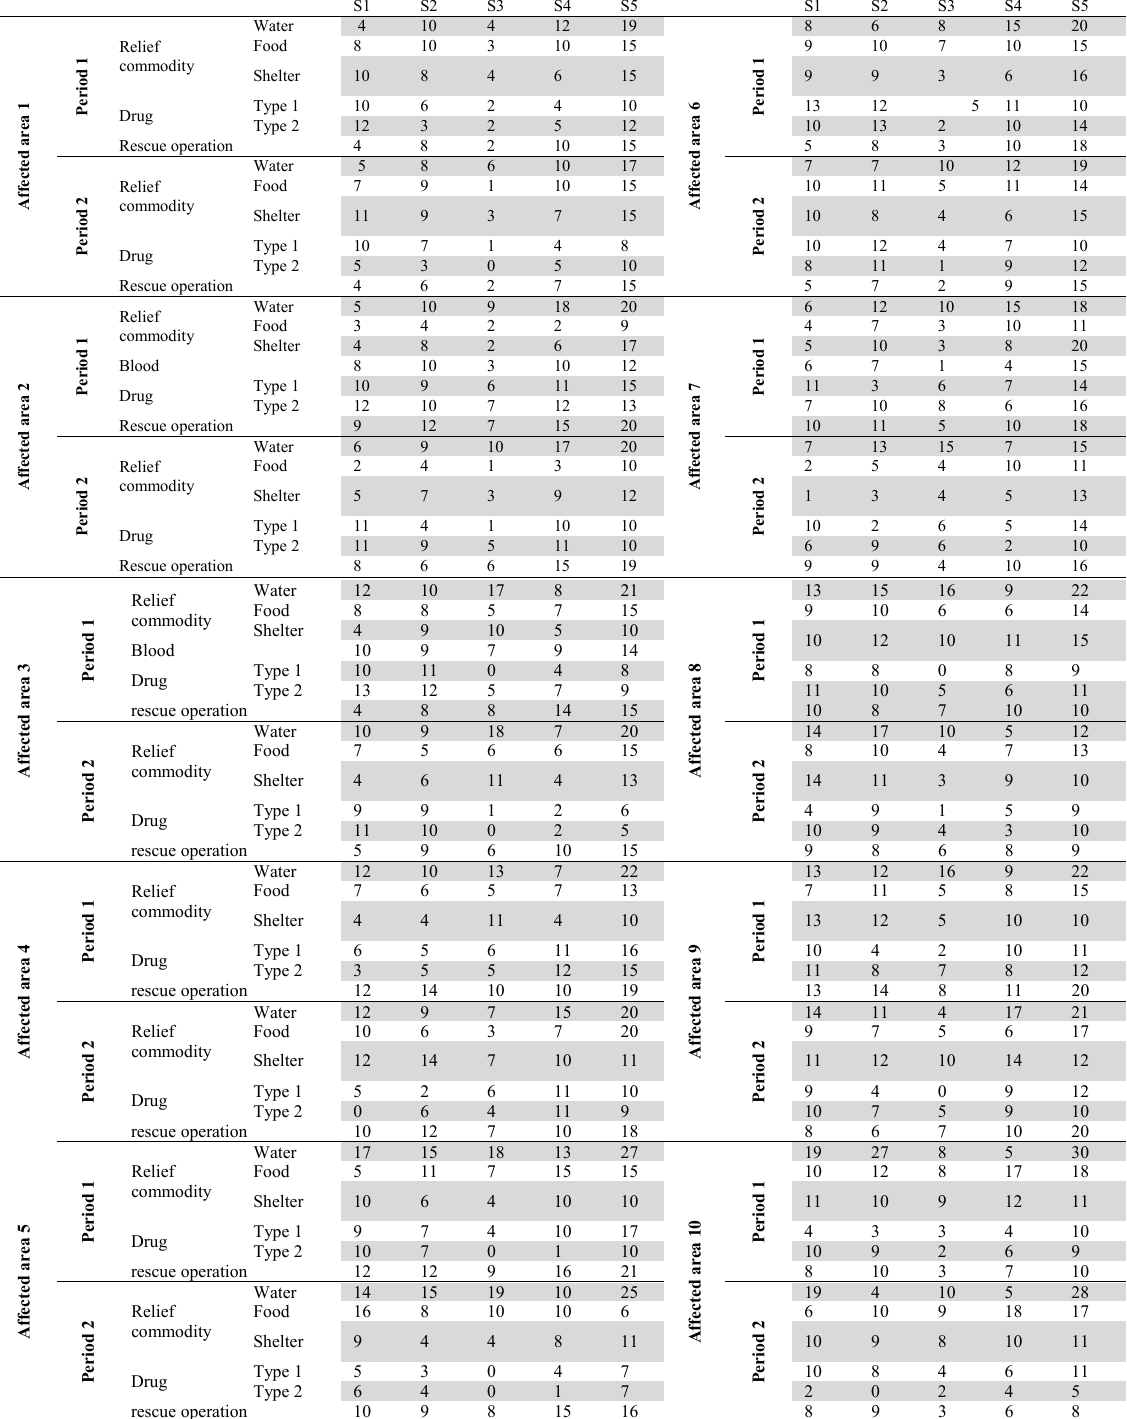
Demand for aid commodities and rescue operation under each scenario and for two time